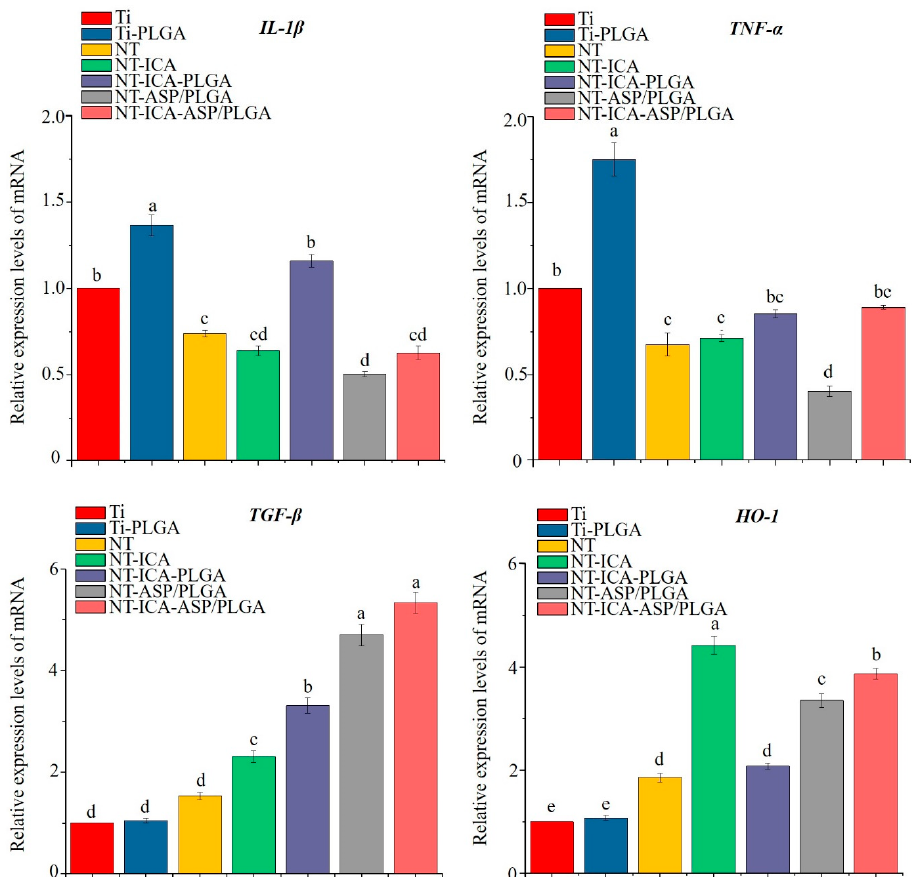
Figure 7. Real-time PCR results of interleukin-1 β (IL-1 β ), tumor necrosis factor-alpha (TNF-a), transforming growth factor-beta (TGF- β ) and heme oxygenase-1 (HO-1) gene expression levels in the RAW 264.7 cells on different substrates after 3 days of incubation. Different lowercase letters indicate statistically significant differences between different groups (p < 0.05). Data are mean ± SD, n = 3 replicates each group.